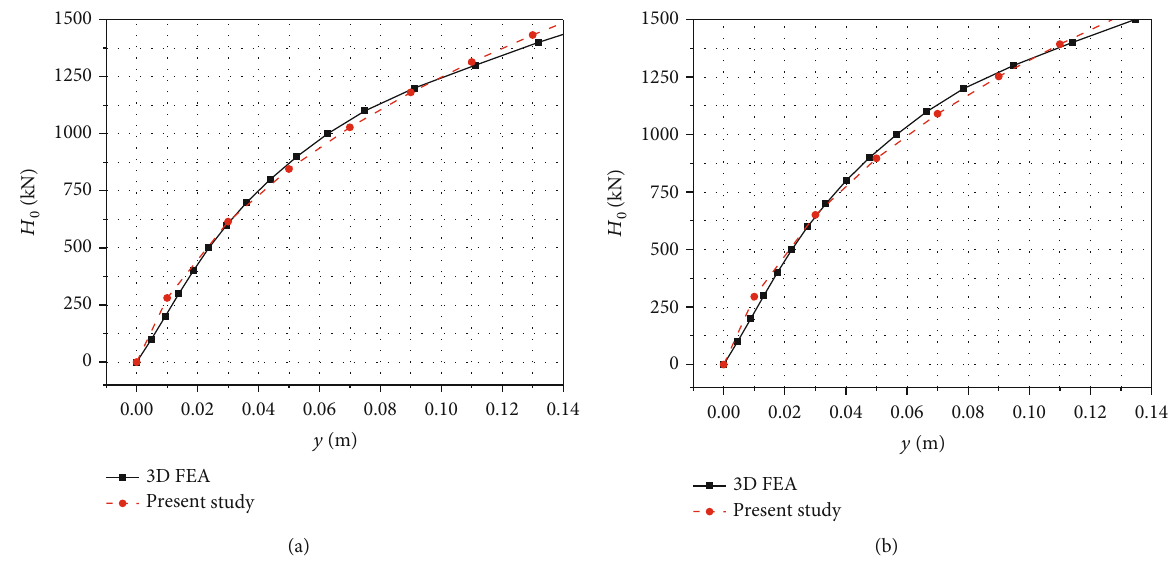
Figure 13: Load and displacement curve of pile head predicted for Case 2. (a) Considering θ